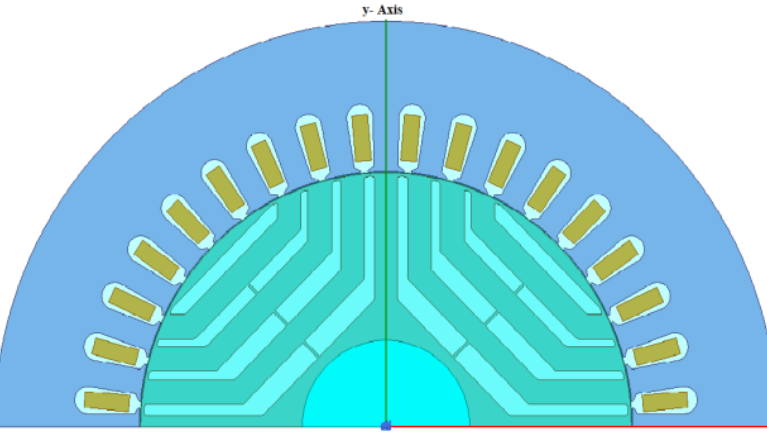
Figure 2. The overview of the initial design.